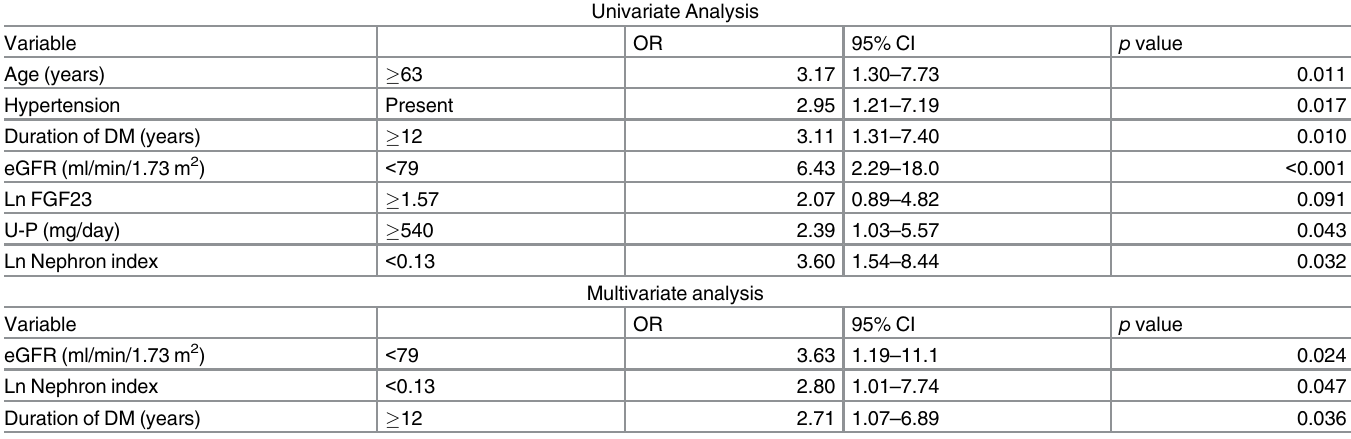
Table 3. Multivariate logistic regression analysis showing independent variables in the assessment of patients with macroangiopathy. DM, diabe- tes mellitus; eGFR, estimated glomerular filtration rate; FGF23, fibroblast growth factor 23; U-P, 24-h urinary excretion of phosphate; OR, odds ratio. Univariate